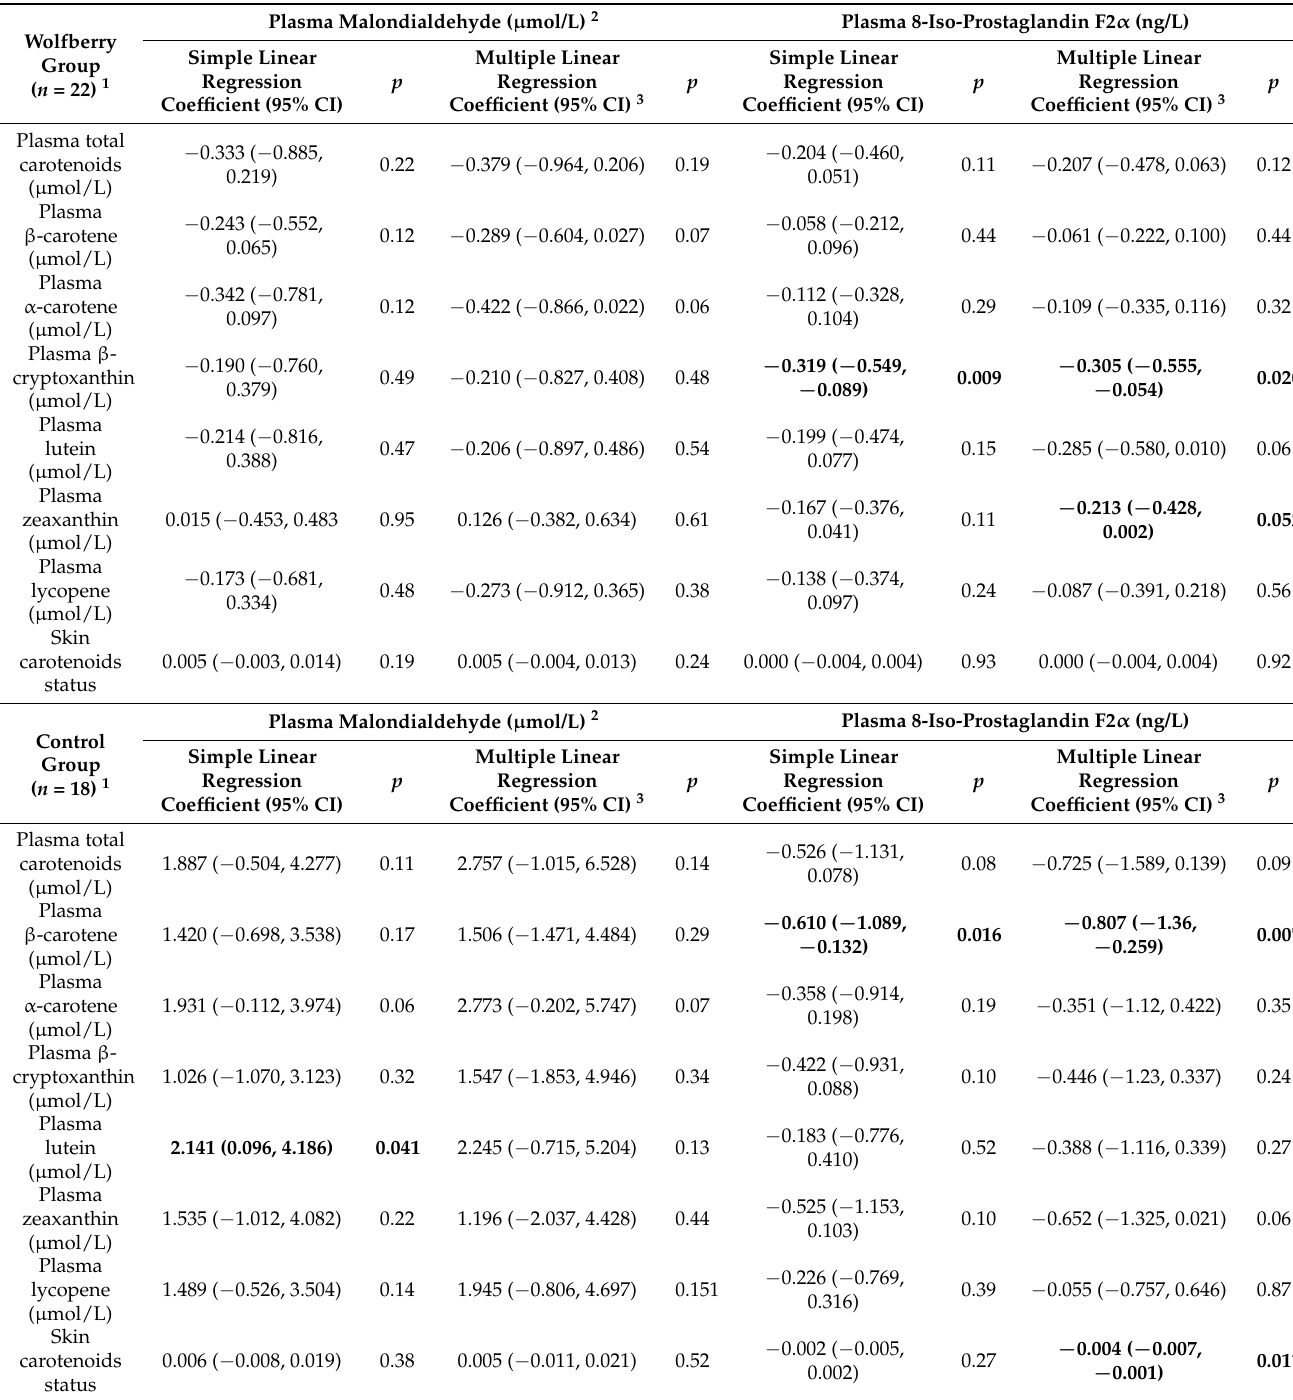
Table 2. Associations between changes for plasma and skin carotenoids status with corresponding changes in the biomarkers of oxidative stress by intervention